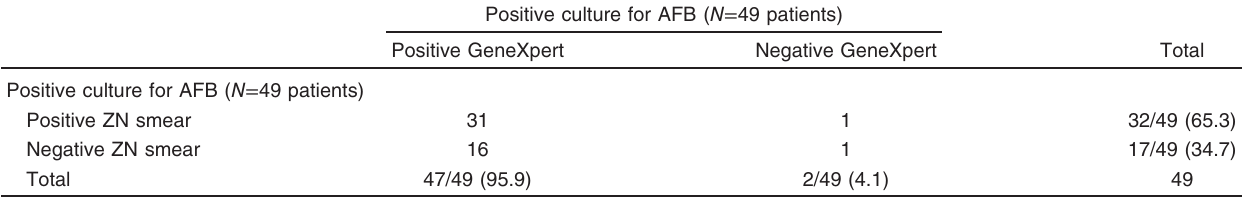
Table 2 GeneXpert test and Ziehl – Neelsen examination results among patients with positive culture for tuberculosis